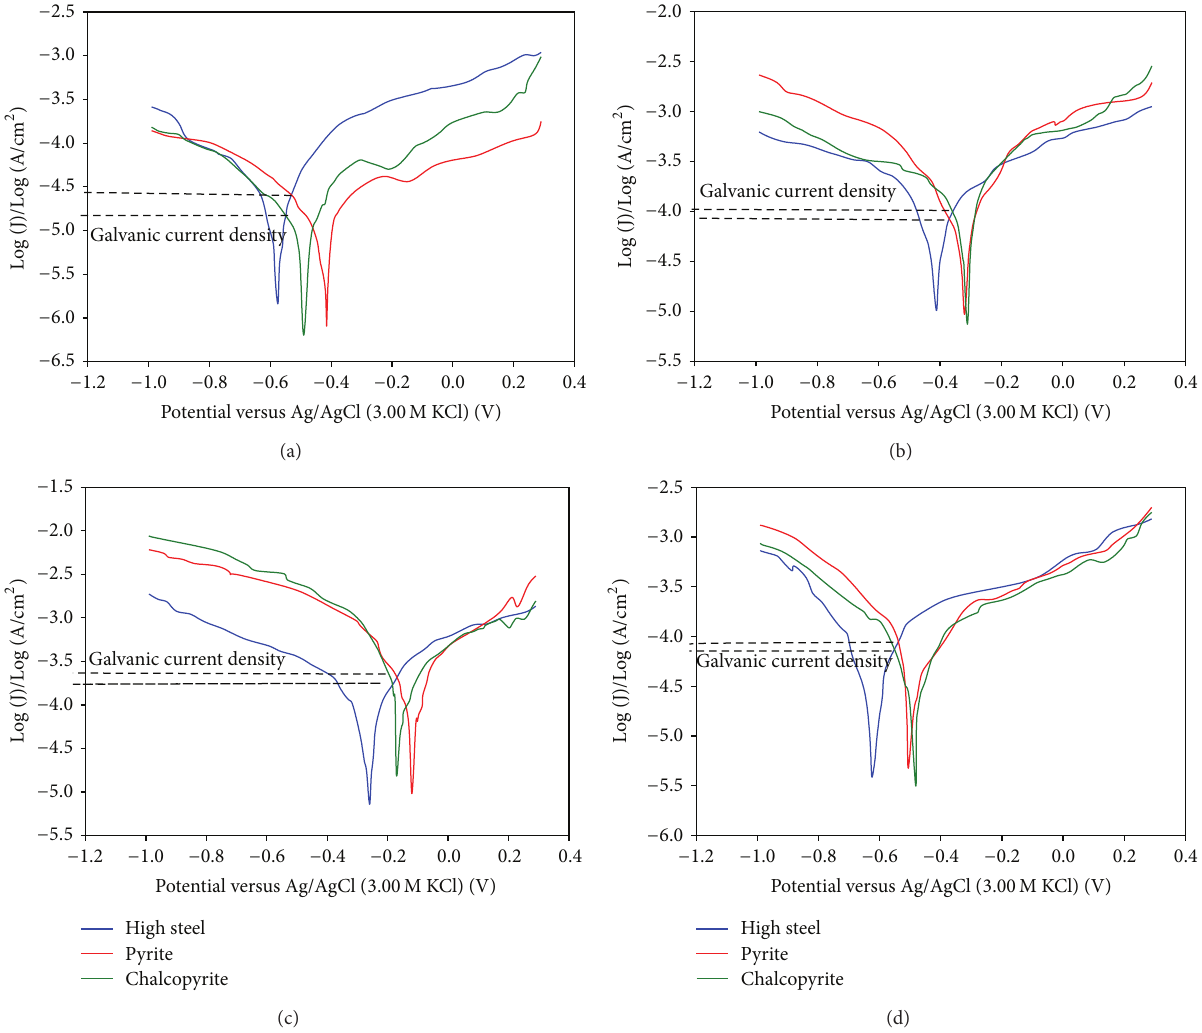
Figure 3: Potentiodynamic polarization sweep curves of grinding medium, pyrite, and chalcopyrite during grinding of ore with high carbon chrome steel ball under nitrogen (a), air (b), and oxygen atmosphere (c), and without aeration (d) at a sweep rate of